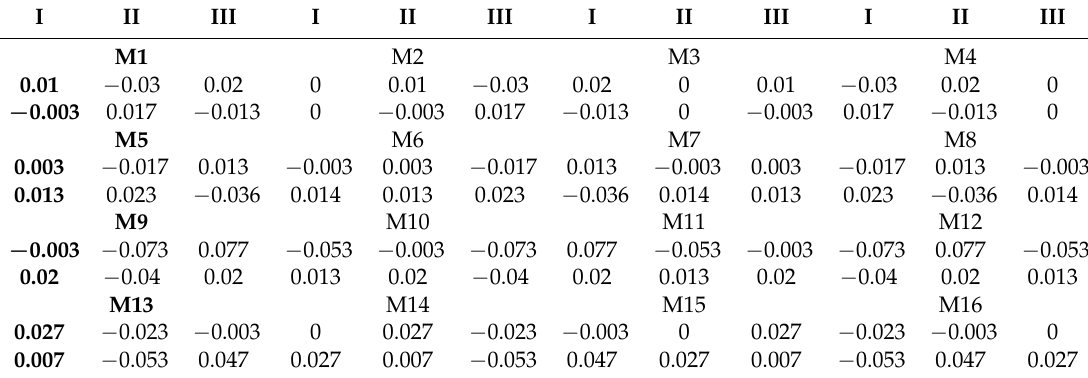
Table 4. Coordinate error of different methods for solving the centroid of point source target image (unit: